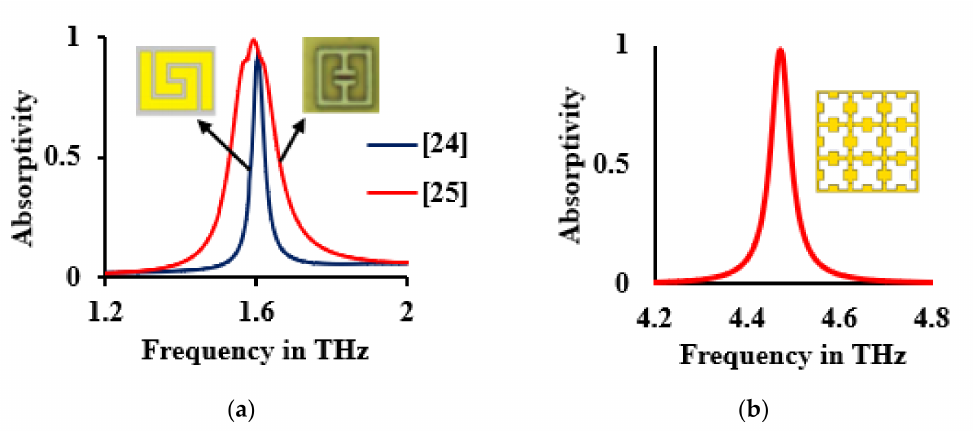
Figure 6. Absorption characteristics of ( a ) Spiral absorber and split ring resonator, ( b ) Proposed sensor.